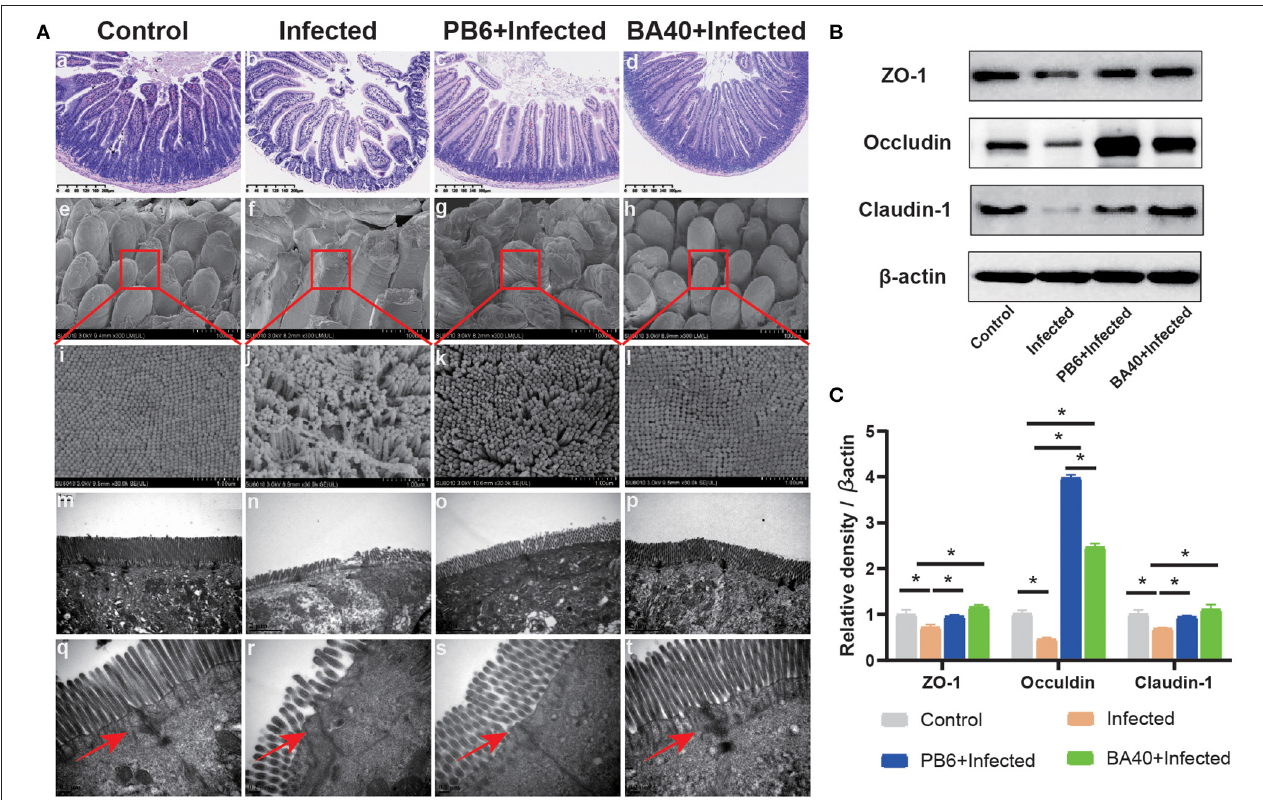
FIGURE 3 | BA40 alleviated intestinal mucosal injury (A) Jejunum tissue stained with hematoxylin and eosin (H&E) (bars = 300 µ m) (a–d). Scanning electron microscopy (SEM) images at × 150 (e–h) and × 30,000 (i–l) fold magnifications. Transmission electron microscopy (TEM) images of the jejunum tissue at × 15,000 (m–p) and × 20,000 (q–t) fold magnifications. (B) Western blot analysis of tight junction proteins (TJs) expression. (C) The relative levels of TJs quantified by densitometry and normalized to β -actin. ( * represented significant differences, P <